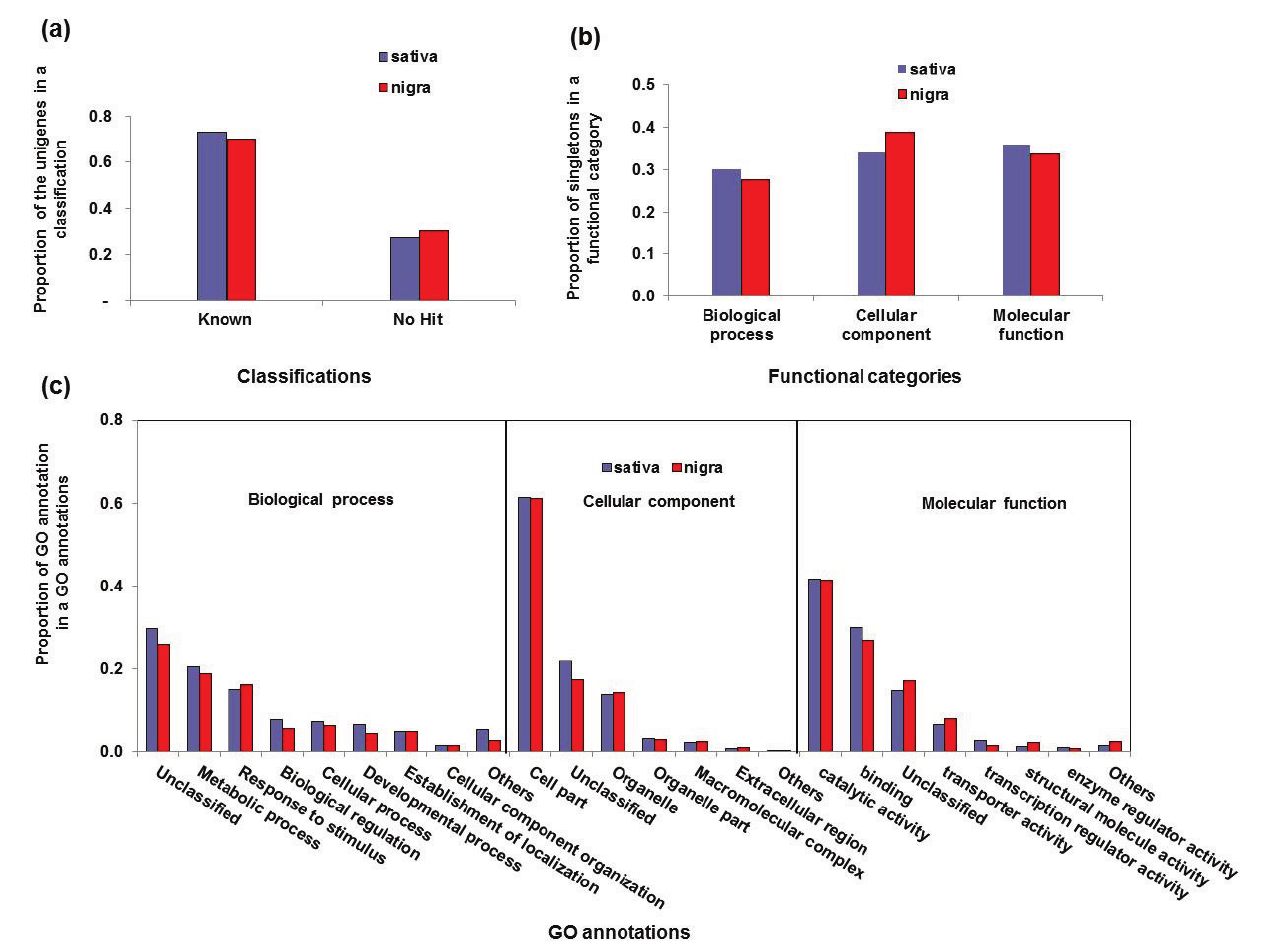
Figure 1. Summary of the functional annotation using the Gene Ontology (GO) approach for Vicia sativa unigenes by the classification ( a ); GO functional categories ( b ) and individual GO annotations ( c ) in between the Vicia sativa nigra and sativa